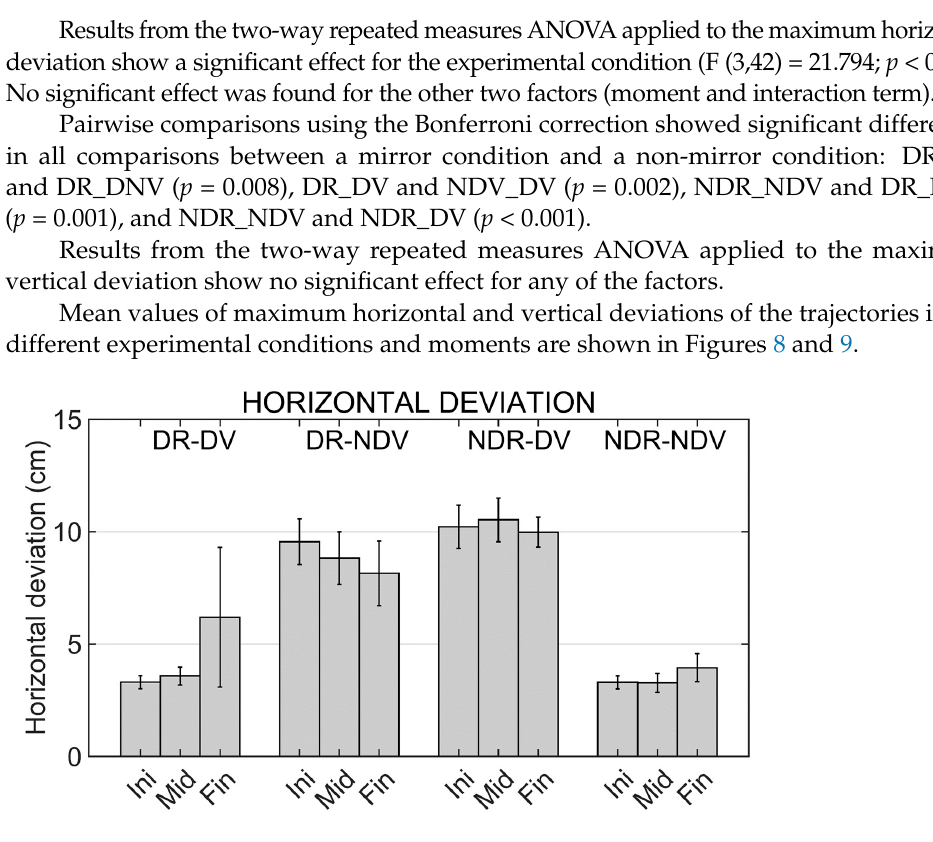
Figure 8. Trajectory maximum horizontal deviation in the different experimental conditions (DR_DV, DR_NDV, NDR_DV and NDR_NDV) and in the different moments of the training (Initial, Middle and Final moments). Mean values and standard errors of the mean are shown.